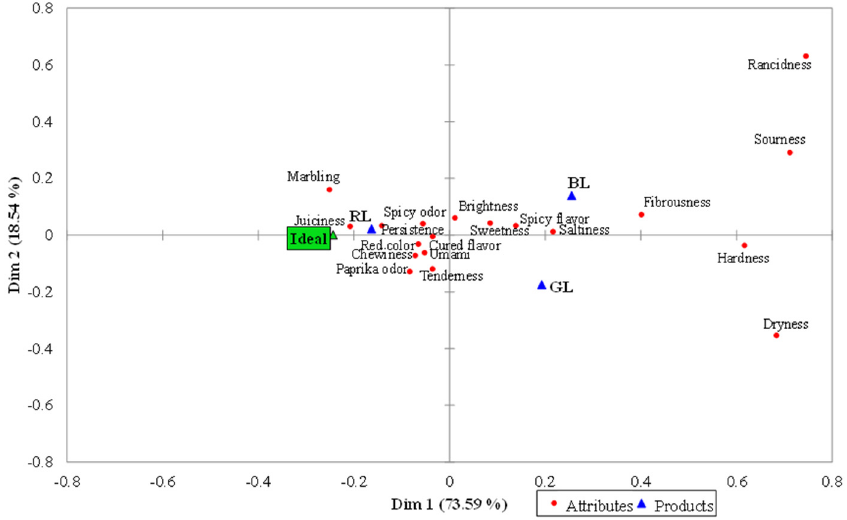
Figure 1. Correspondence Analysis (CA) of CATA term (attributes) frequencies for the three commercial categories of Iberian dry-cured loins: green label—GL (Cebo de Campo Ib é rico), red label—RL (Bellota 50% Ib é rico), black label—BL (Bellota 100%) and Ideal. RL samples obtained the highest overall liking values (4.07 ± 0.06) in comparison with GL (3.54 ± 0.07), and BL (3.58 ± 0.09). The representation of the sensory attributes that